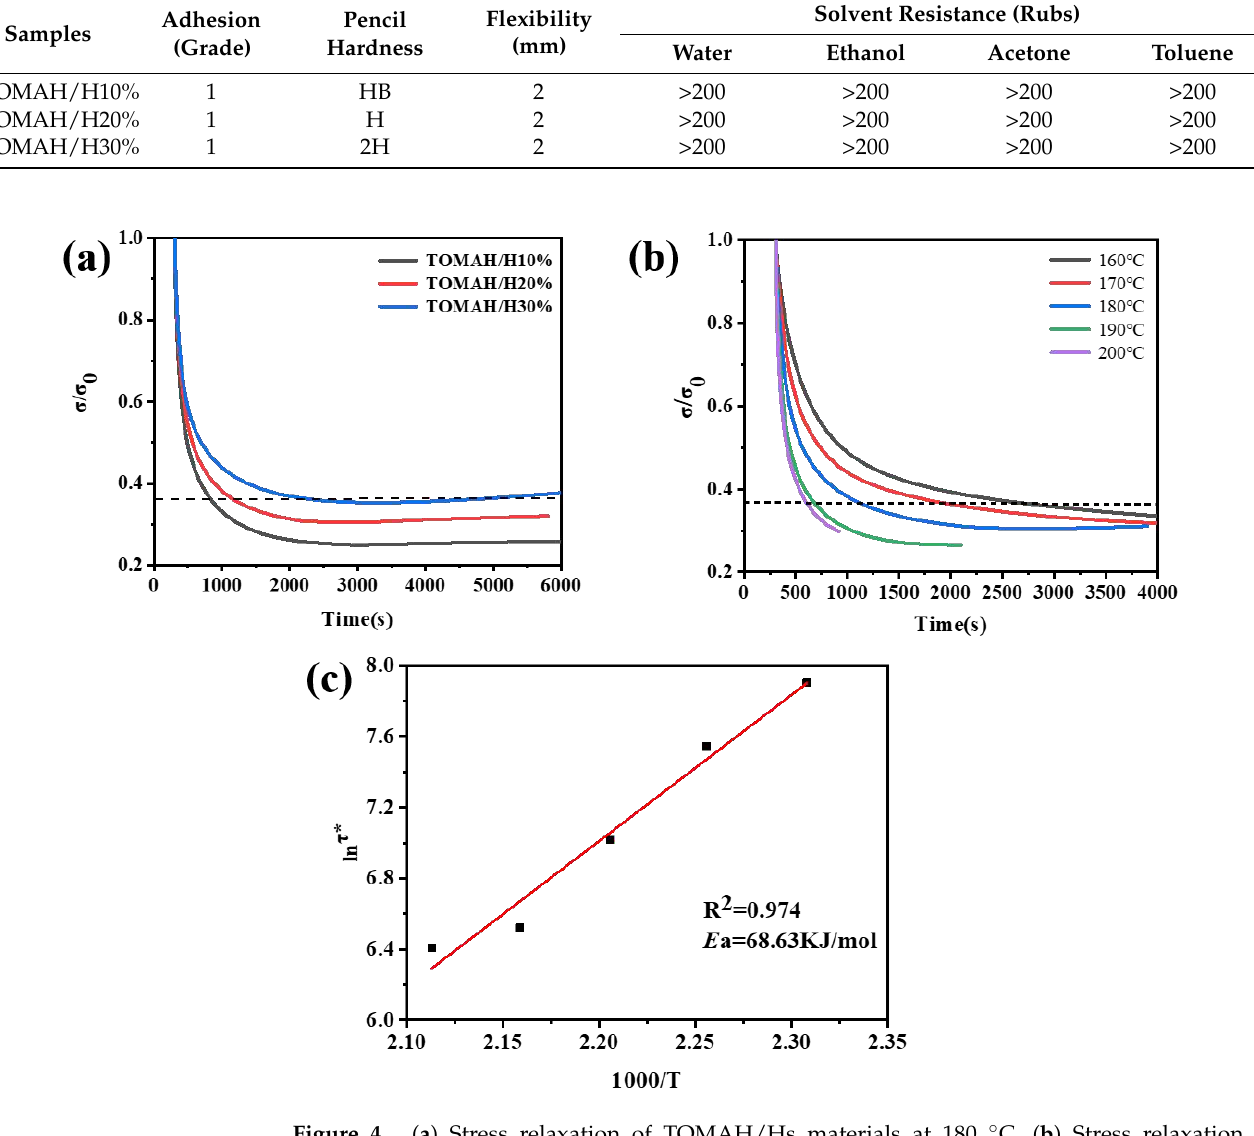
Figure 4. ( a ) Stress relaxation of TOMAH/Hs materials at 180 °C. ( b ) Stress relaxation of TOMAH/H20% with different temperatures. ( c ) Their activation energy was calculated by the Arrhenius equation.